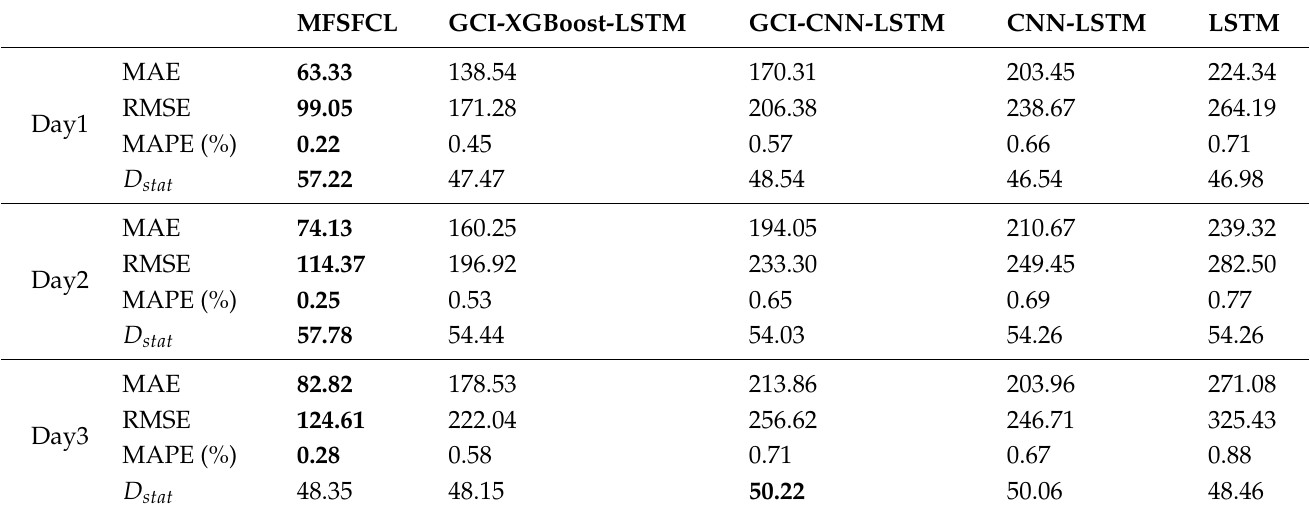
Table 5. Forecasting performance evaluation matrix under different scenarios in the ablation experi-